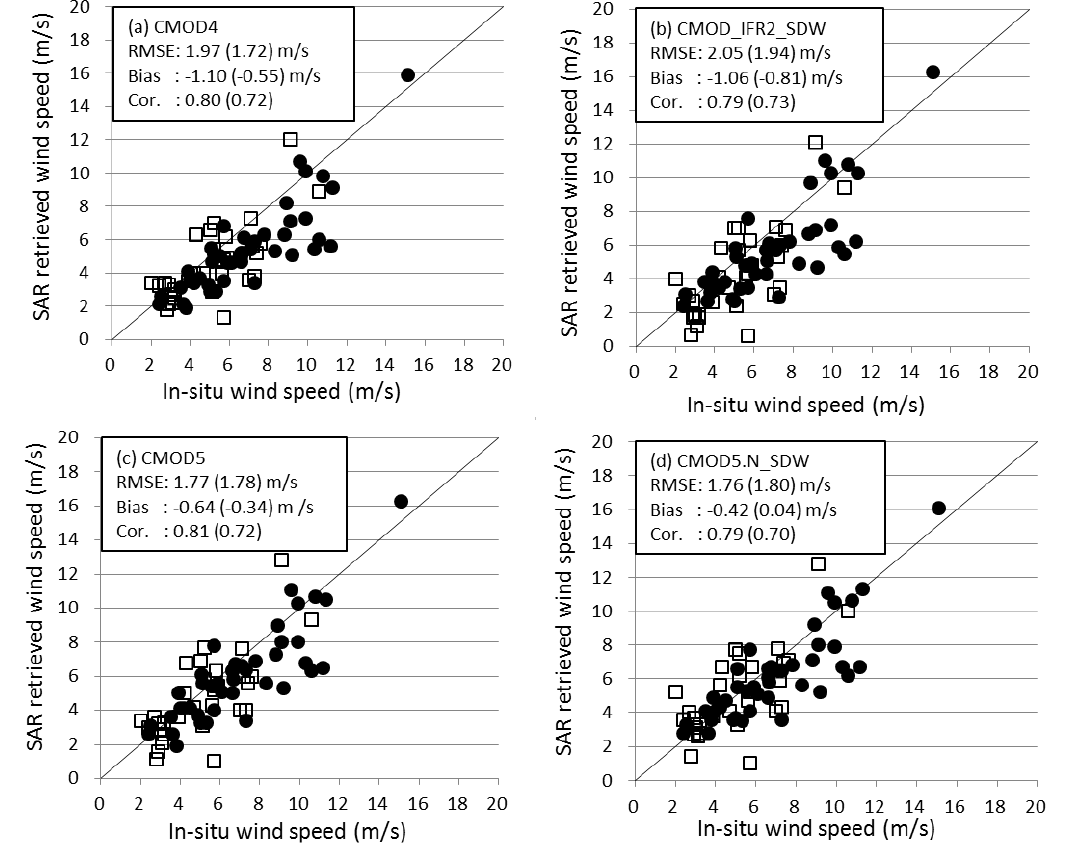
Figure 4. Same as Figure 3, but for 73 cases observed by IMP (daub circle) and WSM (square) at Shirahama. The statistics are for 73 cases, and those for WSM (31 cases) are in parentheses.